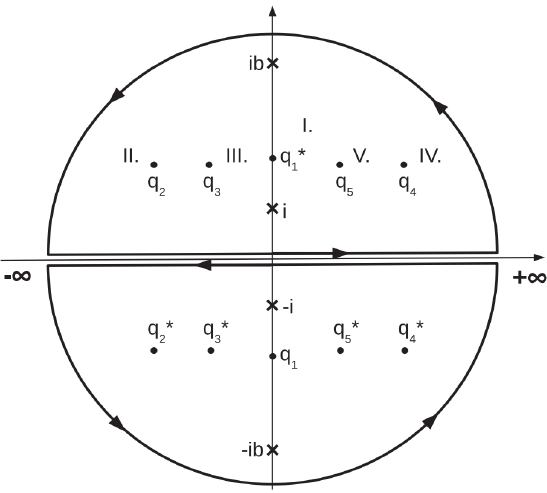
Figure 2. Poles ( × ) and branch points ( • ) of the integrands φ 1 ( q (cid:48) ) and φ 2 ( q (cid:48) ) with contours of integra- tions in the upper and the lower half q -planes,